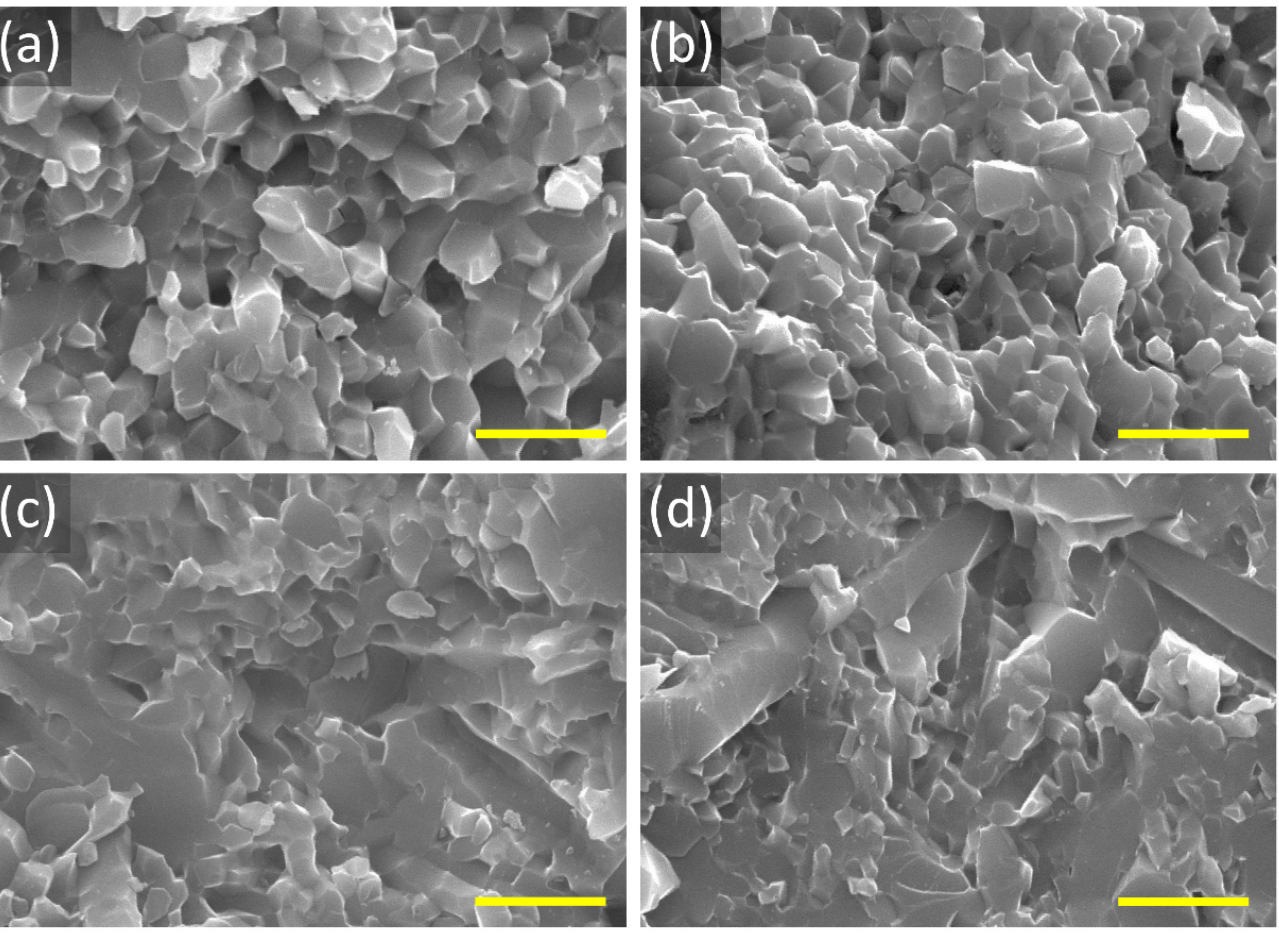
Figure 2. SEM images of the fracture surface of the Ho-SiAlON ceramics ( a ) H10, ( b ) H11, ( c ) H15, and ( d ) H20. The scale bar is 5 µm in all the images.